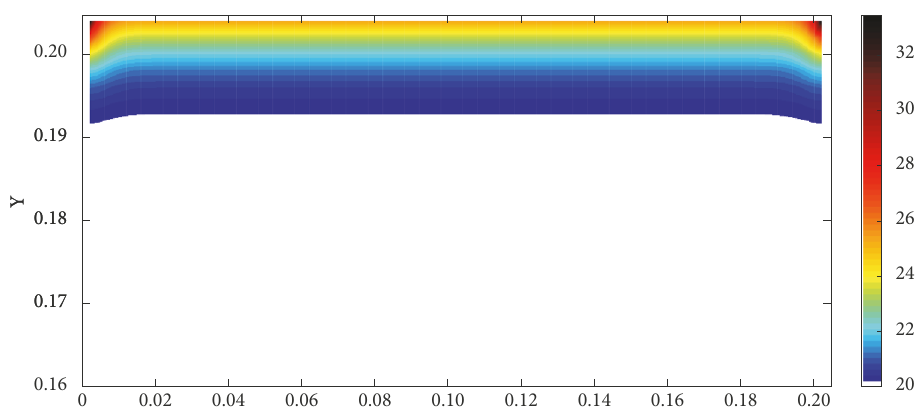
Figure 6: The temperature field in the